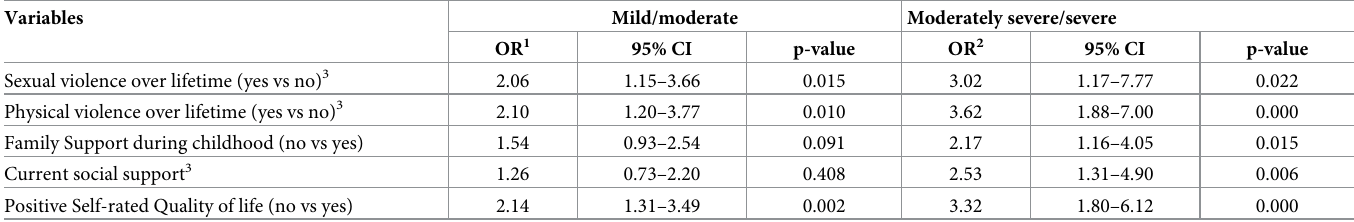
Goodness-of-Fit (Hosmer-Lemeshow Test) of the multivariate final model = 12.6; p = 0.126; 8 df) 1 Weighted odds ratio comparing mild/moderate SMDD with no SMDD for each characteristic 2 Weighted odds ratio comparing moderately severe/severe SMDD with no MDD for each characteristic. 3 See text for